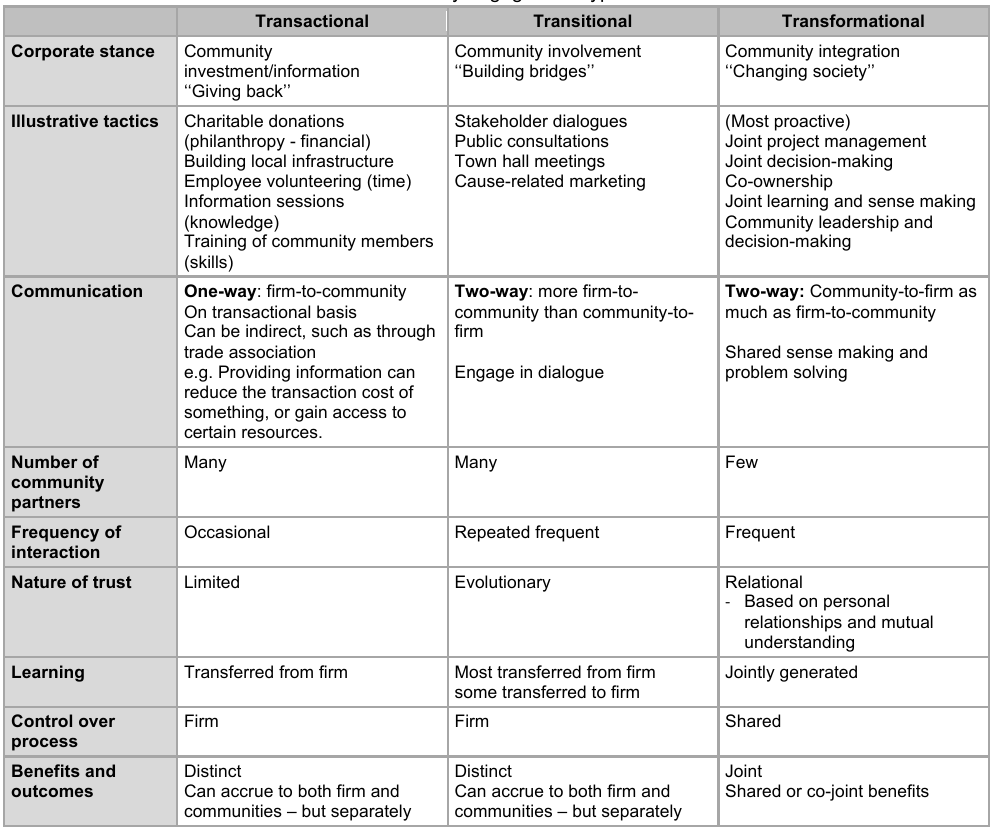
Community engagement